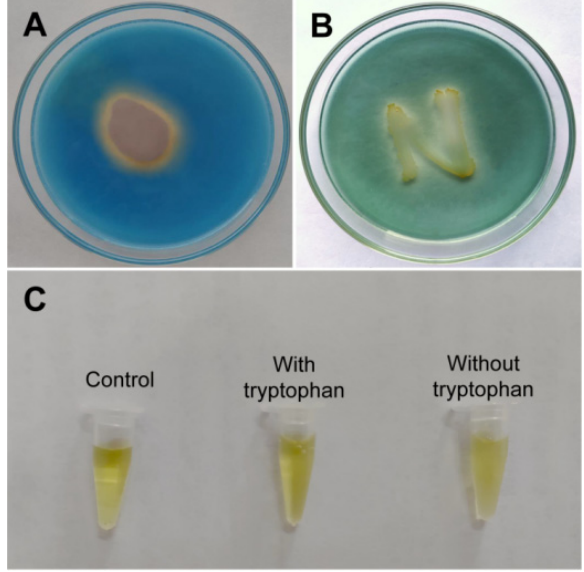
Figure 4. The plant growth-promoting determinants produced by B. subtilis SF1. ( A ) The siderophores production on CAS agar. ( B ) The organophosphorus solubilization assay on NBRIP. ( C ) The IAA production in LB with or without Tryptophan.